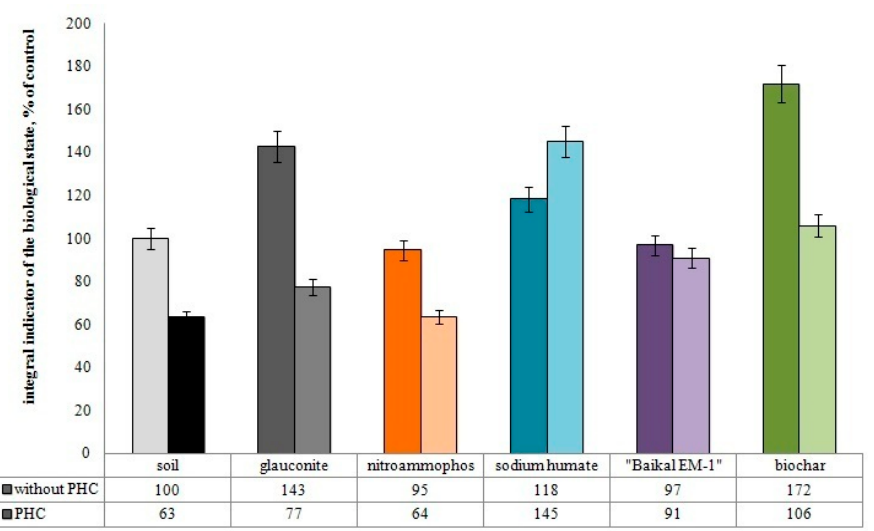
Figure 13. Change in the integral indicator of the biological state of Haplic Chernozem Calcic after adding various bioremediators, %. Note: PHC, petroleum hydrocarbon.